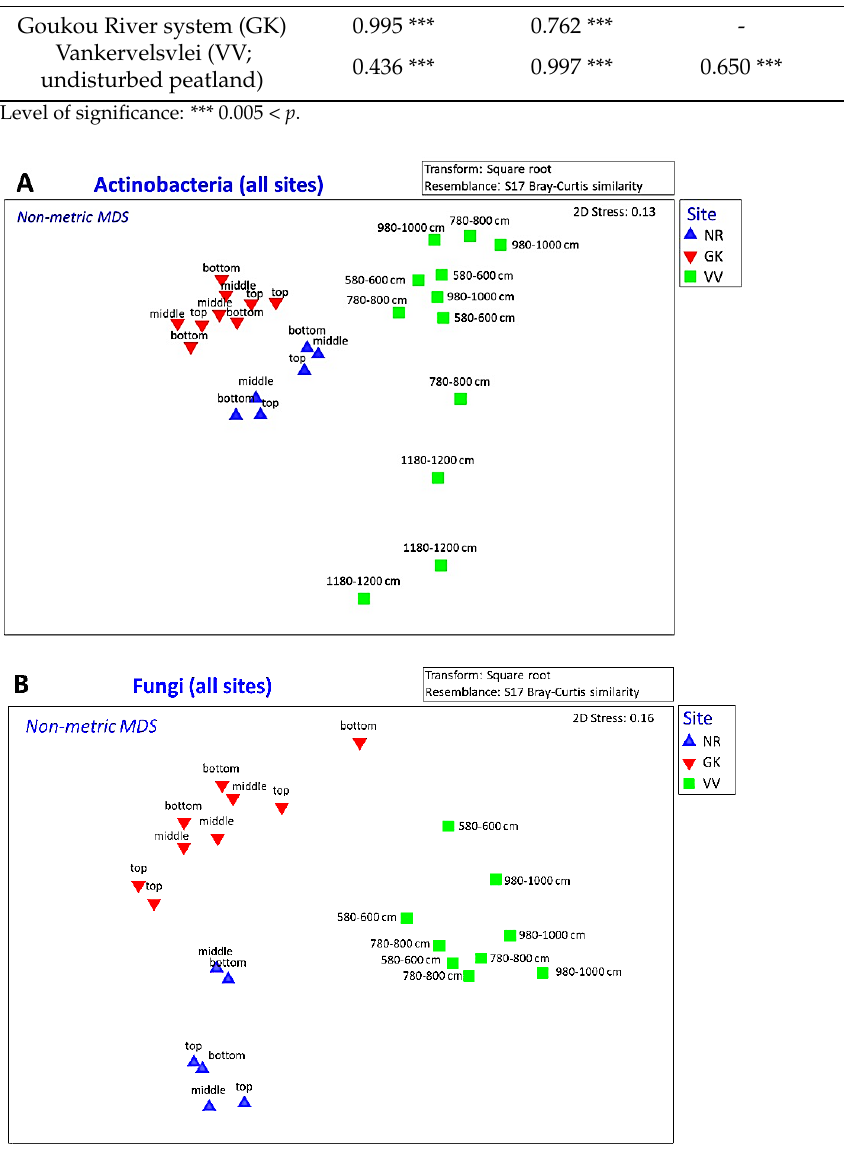
Figure 5. Non-metric multidimensional scaling plot showing similarities of the actinobacterial ( A ) and fungal ( B ) community structure from all the sites at different depths, and the actinobacterial community structure ( C ) from Vankervelsvlei at different depths. ‘Top’ = 0 to 5 cm depth , ‘middle’